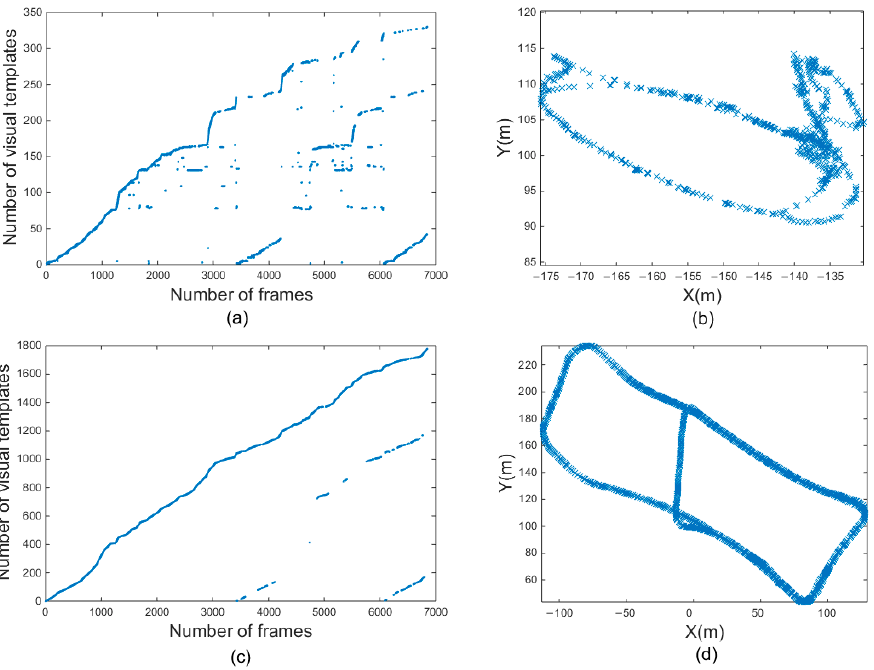
Figure 13. Experimental results of the third scene. ( a , b ) are visual templates and experience map output by traditional RatSLAM. ( c , d ) are visual templates and experience map output by RatSLAM based on HSI model.